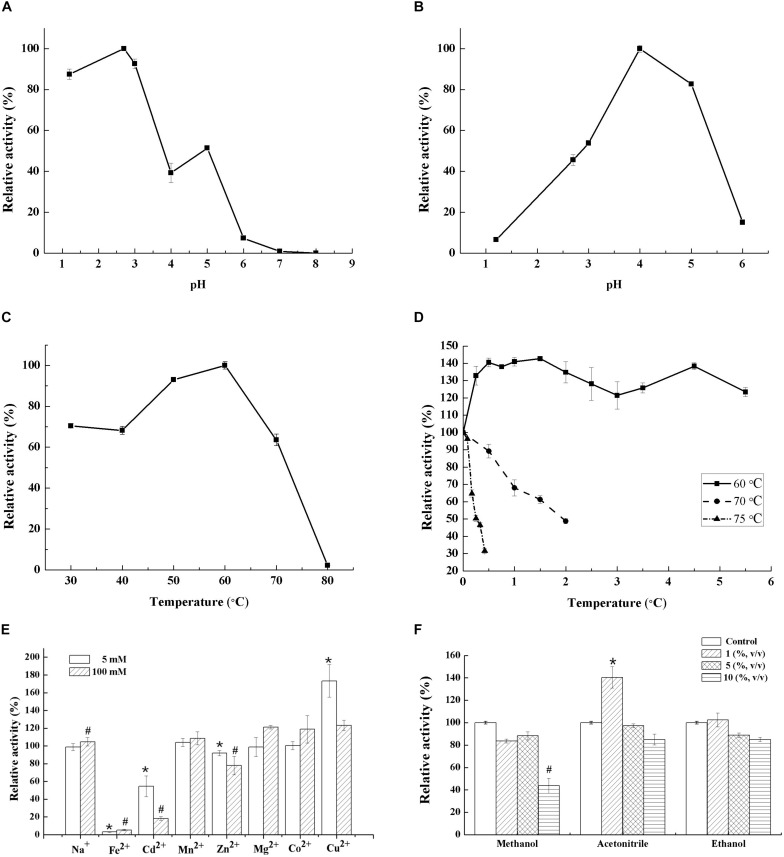
Characterization of Lac 37 II. Effect of pH on laccase activity (A) and stability for 36 h (B). Effect of temperature on laccase activity (C) and stability (D). Effect of metal ions (5 or 100 mM) and organic solvent on laccase activity (E,F). Laccase activity that without heat treatment, metal ions, and organic solvent at pH 4.8 was 343.06 U/mg. Activity is represented as % relative to laccase activity under the standard conditions, assigned as 100% for stability studies. The maximum laccase activity was recorded as 100% for the optimal temperature and pH studies. The data are presented as means from three independent measurements ± the standard deviations (indicated by the error bars). *p and #p < 0.05, as determined by one-way ANOVA.